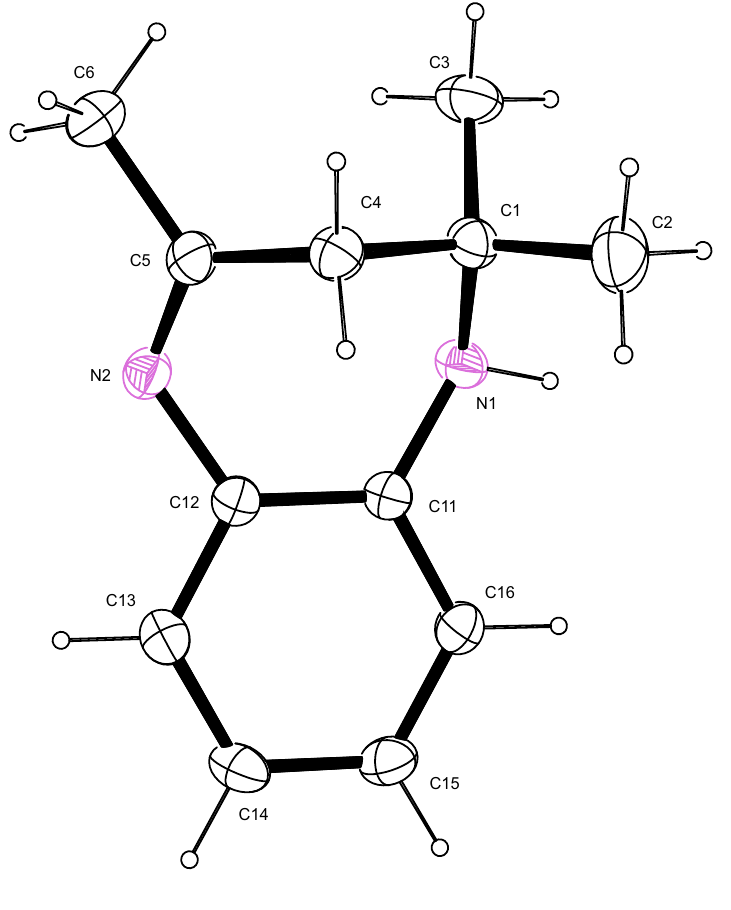
Figure 4. An ORTEP view of II showing 50% probability displacement ellipsoids and the atom